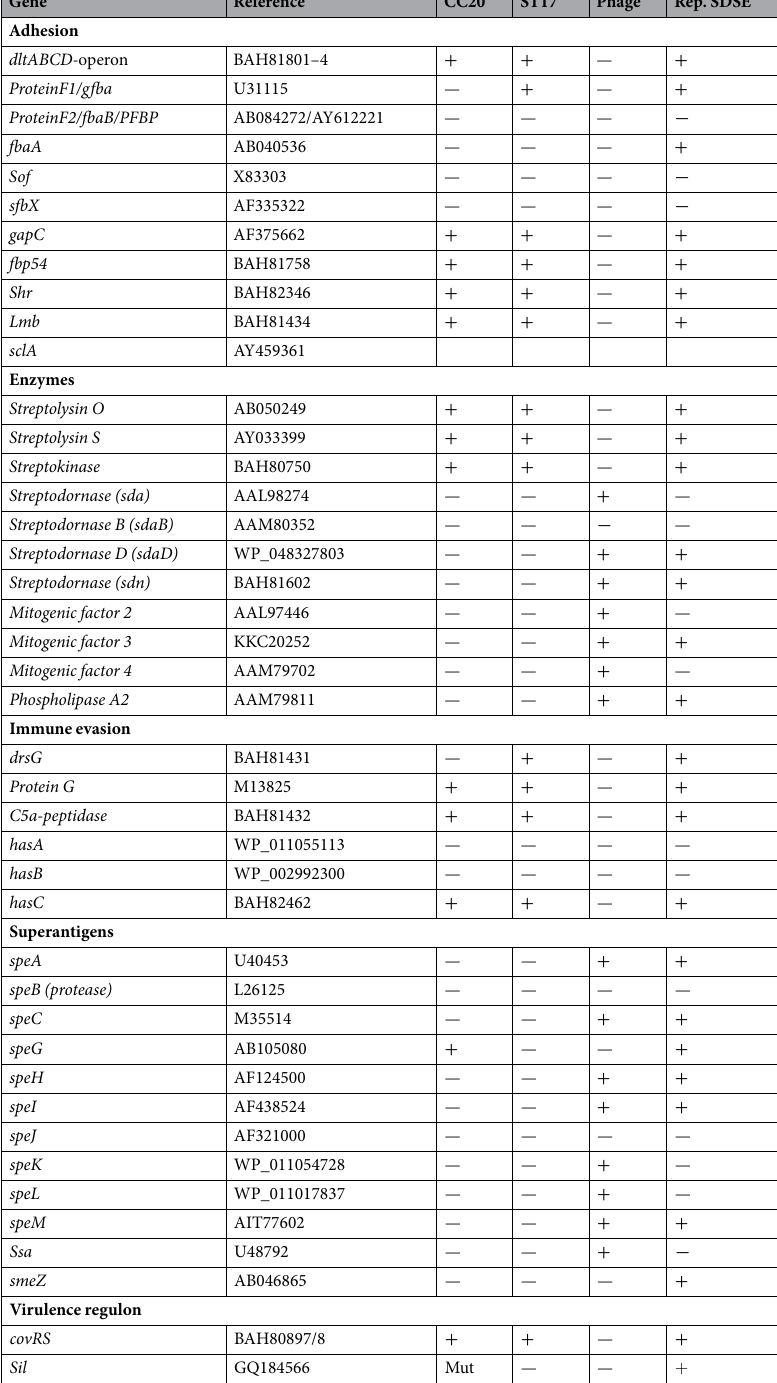
Table 1. Genetic repertoire of the invasive stG62647 -isolates. CC20, stG62647 -isolates belonging to clonal complex 20; ST17, stG62647 -isolate belonging to MLST-profile 17; Phage, bacteriophage-associated; Rep. SDSE, previously reported in SDSE; Mut, mutated. Symbols + and–denote presence or absence of genetic feature,